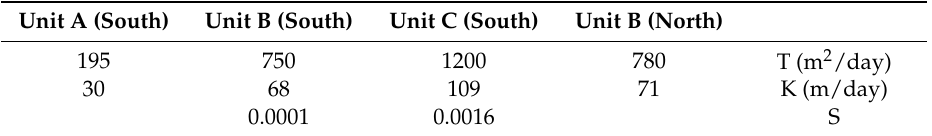
Table 3. Hydraulic Transmissivity, conductivity, and Storativity, determined by field tests (slug, point dilution, and the interference recovery